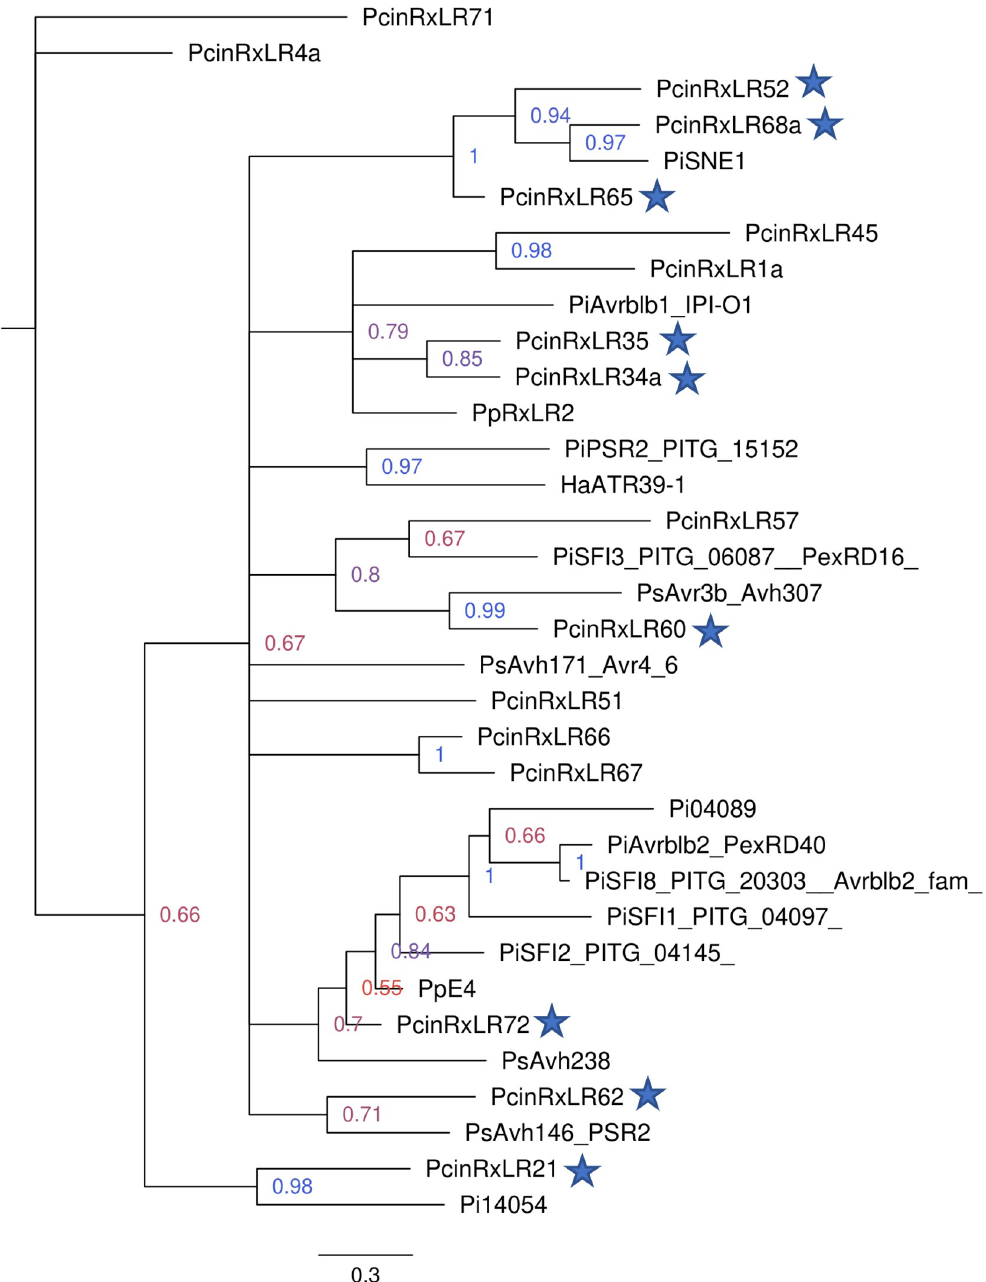
Fig 2. Evolutionary relatedness of Phytophthora cinnamomi candidate RxLRs to characterised effector proteins from other oomycete species. A phylogenetic tree was produced from Bayesian inference analysis of the predicted N-terminal regions of the P . cinnamomi candidate RxLR effectors aligned with the N-terminal regions of functionally characterised RxLRs in other species. Uninformative sequences from a preliminary phylogenetic analysis were removed to produce the refined tree above. Support for branches is indicated by posterior probability values, shown up to the second significant digit for each node. Probability value colours fall on a spectrum ranging from red (lowest probability values) to blue (highest probability values). Proteins indicated by blue stars are candidate P . cinnamomi RxLR effectors which grouped with characterised RxLRs from other species with a posterior probability equal to or higher than 0.7.